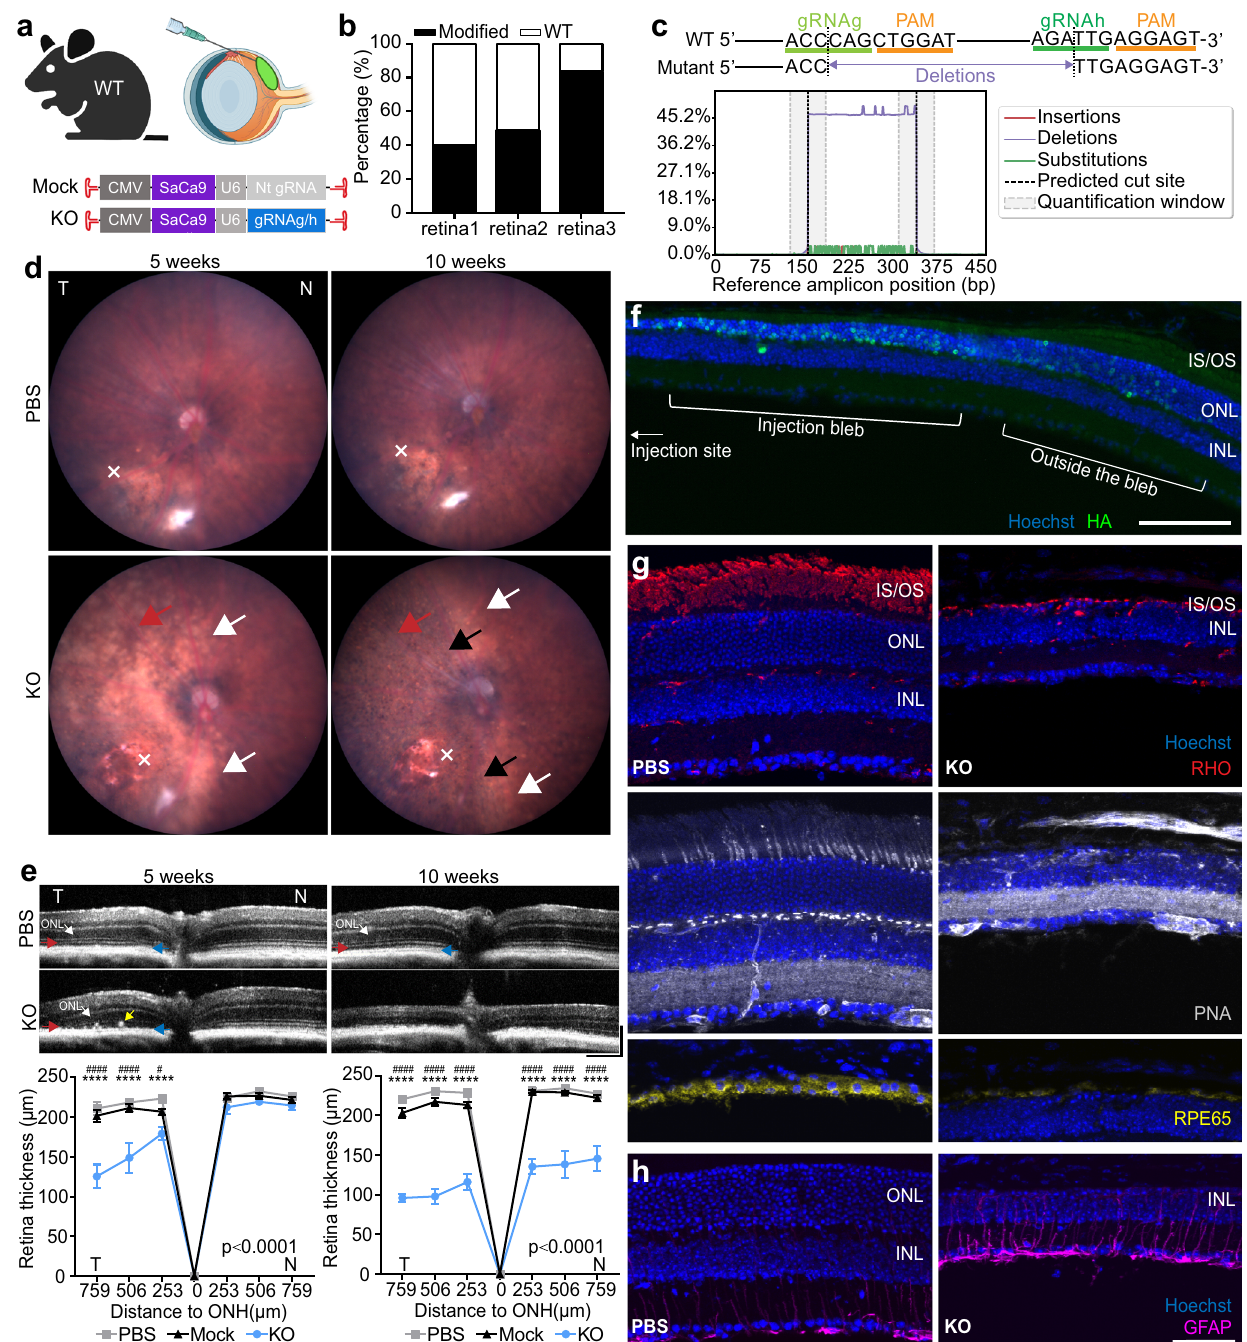
Fig. 2 | Subretinal injection of two Prpf31 -KO vectors results in severe struc- tural changes in outer retina. a Illustration of the experimental approach. AAV 7m8-CMV-SaCas9-U6-gRNAg/h (1.5 µ l, 1.01E+12 vg/ml, gRNAg:gRNAh=1:1) was subretinally injected to WT mice. PBS or mock vector 7m8-CMV-SaCas9-Nt gRNA (1.5 µ l, 4.39+E12 vg/ml) was injected to control eyes. b Deep sequencing of genomic DNA from the injected area of the KO retina 5 weeks (p.i.) revealed 57.29±23.24%editingof Prpf31 atthegRNAg/htargetregion( n =3). c Mutationsin edited Prpf31 .Themaineditingeventidenti fi edwasa~184bpdeletionbetweenthe predictedcutsitesofthetwogRNAs. d Fundusimages.Injectionsweremadeatthe temporal retina (×). At 5 weeks (p.i.), temporal retina of KO eyes showed retina pallor(white arrows).At10 weeks(p.i.),the area ofpallor expanded,and punctate black pigmentation (black arrows) and attenuated retinal blood vessels (red arrows) were observed in the injected area. (PBS n =20, Mock n =15, KO n =37) e OCT of retina and quanti fi cation of total retina thickness (neural retina and RPE)